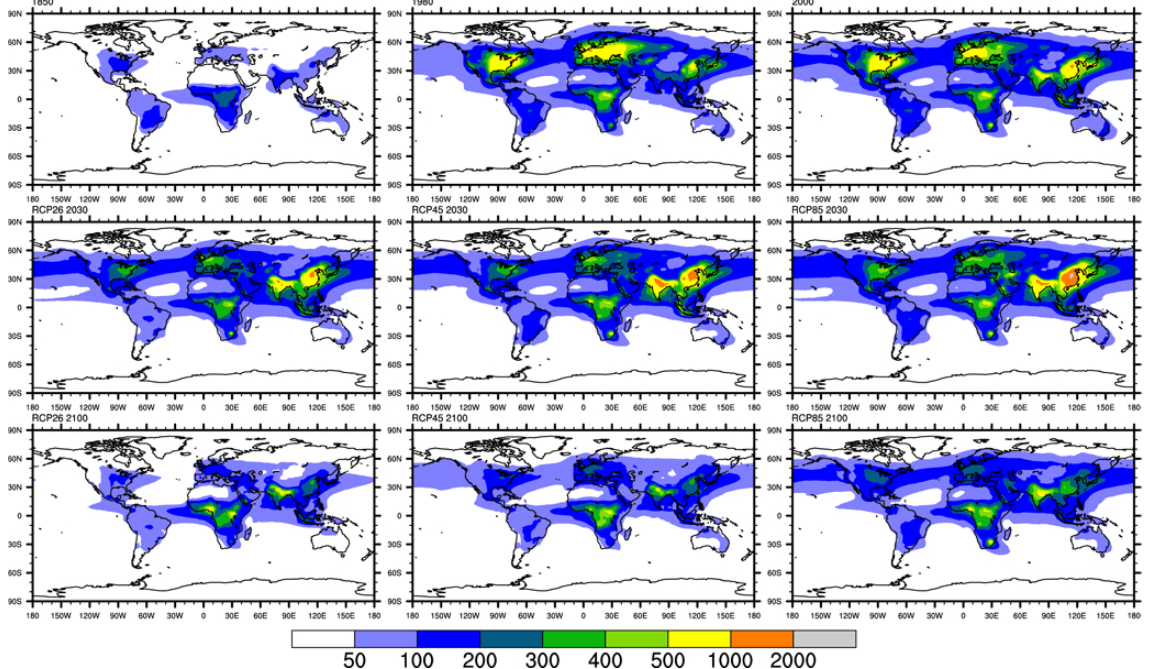
Fig. 5a. Total (wet + dry) NO y deposition 1850–2100(mg(N)m − 2 yr − 1 ). Top row shows 1850, 1980 and 2000. Middle row shows 2030 for RCP2.6, RCP4.5 and RCP8.5. Bottom row shows 2100 for RCP2.6, RCP4.5 and RCP8.5.